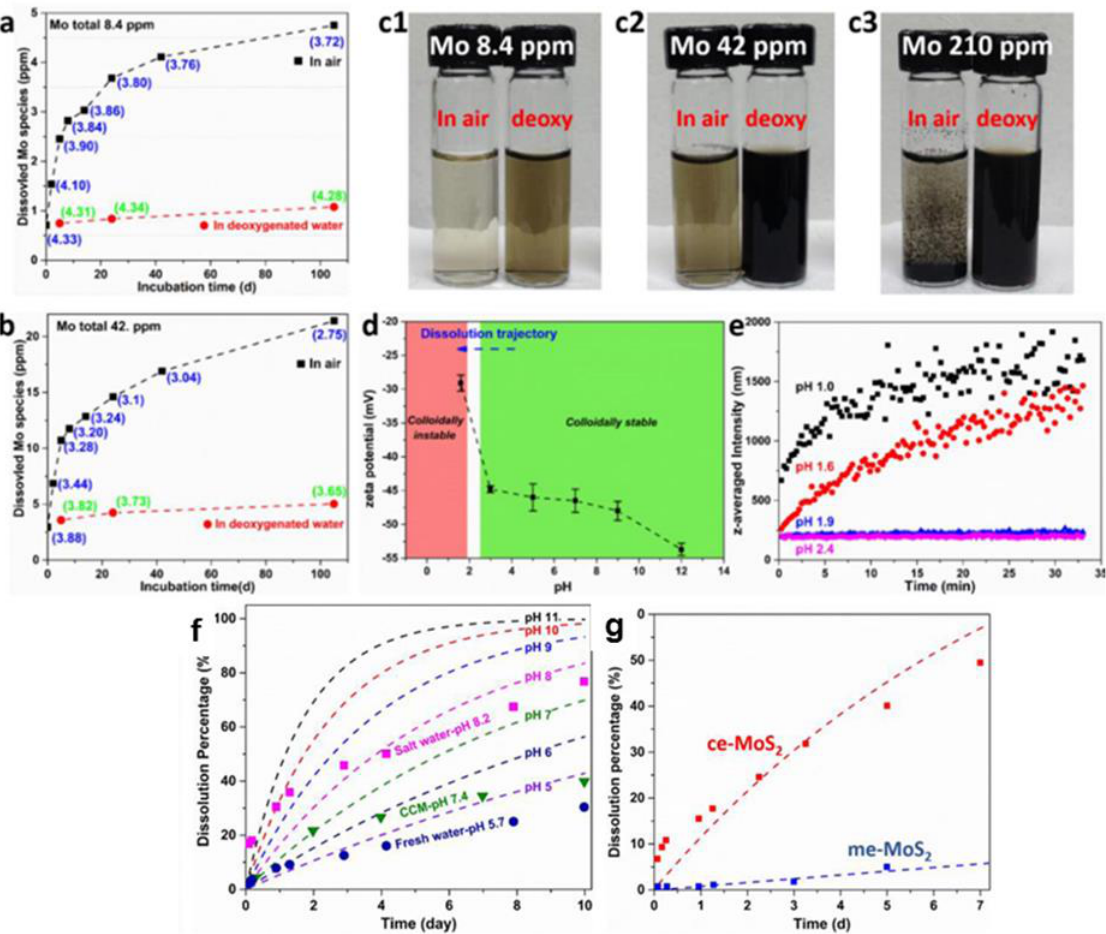
Figure 4. Very defective liquid-exfoliated nanosheets from the MoS 2 powder (ce-MoS 2 ) formed colloidal solution and dissolved in water, when at pH > 2 and at Mo concentrations below 2.2 mM. Less defective, ultrasonically exfoliated nanosheets from the MoS 2 powder (ue-MoS 2 ) dissolved much less. ( a ) Dissolution of ce-MoS 2 nanosheets at low [Mo] of 8.4 ppm corresponding to 0.09 mM Mo in both air-saturated and deoxygenated water. Measured solution pH values are provided in parentheses for each data point. Upon ce-MoS 2 dissolution pH decreases. ( b ) Same, at [Mo] of 42 ppm (0.44 mM Mo). Larger pH decrease was observed upon ce-MoS 2 dissolution than in ( a ). ( c ) Photographs showing that ce-MoS 2 ions were colloidally stable in all dispersions after 105-day incubation, except at the highest starting Mo concentrations (210 ppm or 2.2 mM) in O 2 -containing water. Aggregation of the ce-MoS 2 below pH of 1.9 was confirmed by measurements of zeta potentials ( d ) and hydrodynamic sizes ( e ) at various pH values. Dynamic light scattering was used to measure the change, and the pH of the solution was adjusted by addition of HCl or NaOH to ce-MoS 2 solution ( ∼ 10 ppm of Mo). ( f ) pH-dependent dissolution rates obtained by using various buffer solutions. The lines showed results of an empirical kinetic law. ( g ) Dissolution rates for chemically vs. ultrasonically exfoliated MoS 2 nanosheets in HEPES buffers (pH 7) at [Mo] of 8.4 ppm. Both kinds of MoS 2 nanosheets underwent continuous dissolution, but the kinetics was much slower for the ultrasonically exfoliated samples. Reprinted from Reference [61], with permission. Copyright 2016 American Chemical Society.